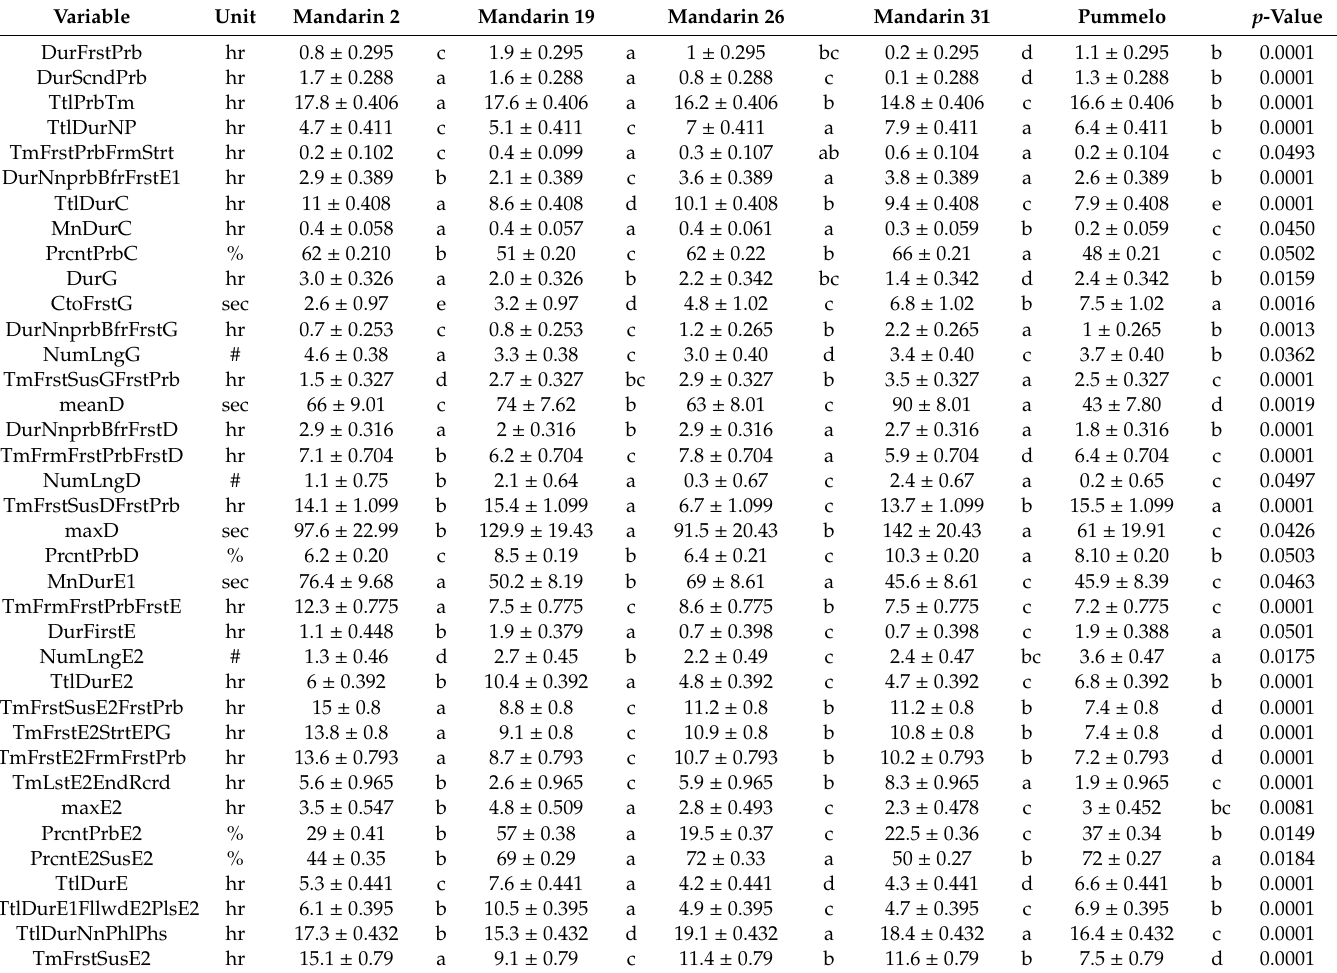
Table 1. Probing behavior of Diaphorina citri on Cleopatra Mandarin selections and